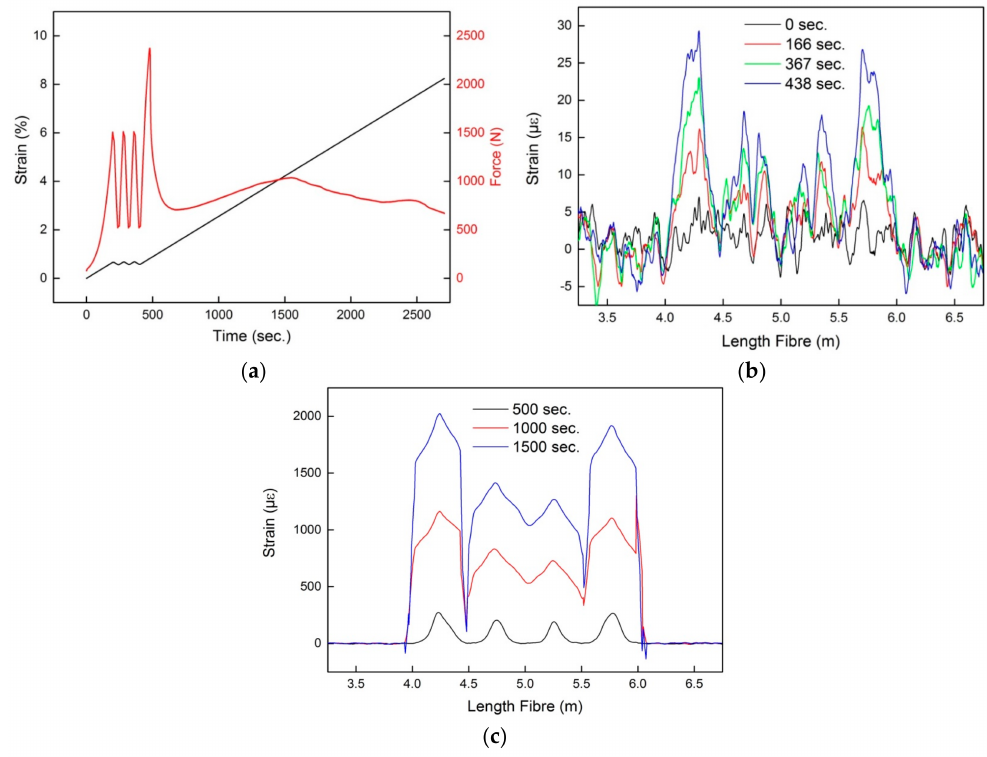
Figure 6. OFDR measurement results; ( a ) Applied strain and force on the concrete block under test; Spatial strain readings of the OFDR before ( b ) and after ( c ) breakage of the concrete block at the load